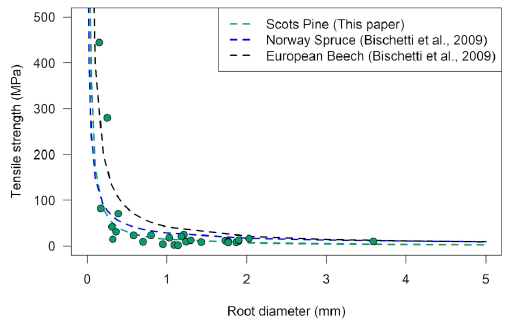
Figure 7. Tensile strength plotted versus root diameter for Scots pine compared to power laws derived for European beech and Nor- way